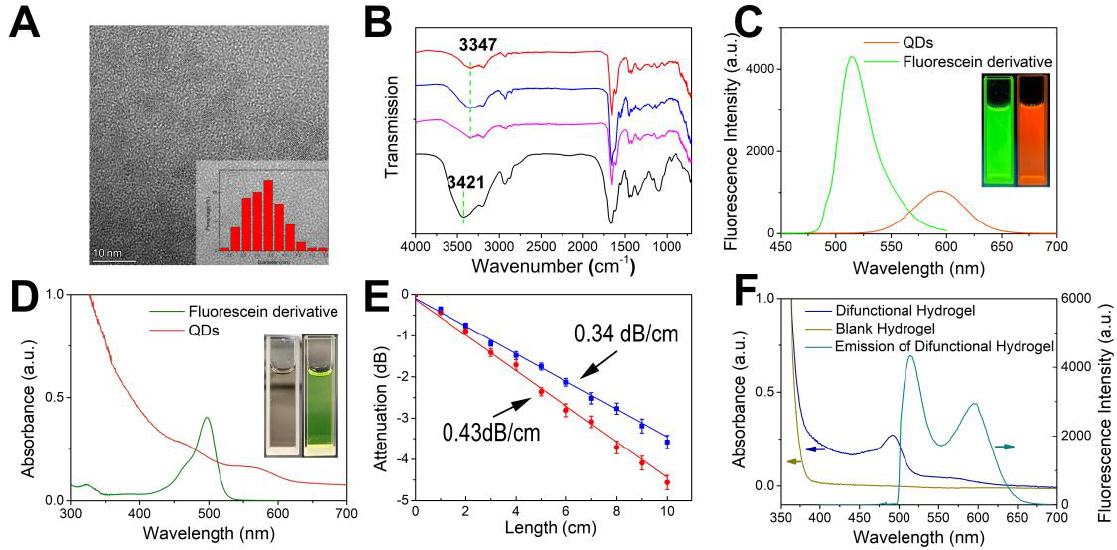
Figure 3. ( A ) TEM image and size distribution of CdTe QDs. ( B ) FT-IR. Top to bottom: blank hydro- gel, amino hydrogel, fluorescein derivative functionalized hydrogel, and 3 − APBA functionalized hydrogel. ( C ) Emission spectra of fluorescein derivative and QDs. Insets: fluorescence photographs of fluorescein derivative and QDs under UV light (365 nm) illumination. ( D ) Absorption spectra of fluorescein derivative and QDs. Insets: solution under white light. ( E ) The propagation loss of hydrogel fibers in the air with/without cladding, measured by a cutback technique. The wavelength of the light was 532 nm. ( F ) Absorption spectra of blank hydrogel and difunctional hydrogel. Dual emission was acquired from the spectrometer of the monitoring system.